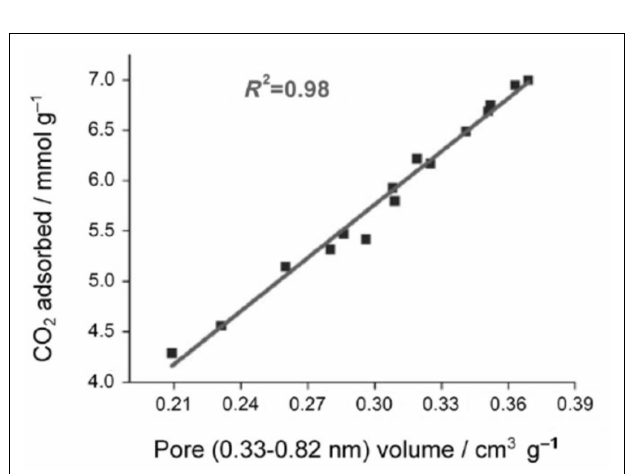
FIGURE 5 |The linearship between CO 2 adsorption capacities (25°C, 1bar) and microporosity, reproduced fromWei et al. (2012) .